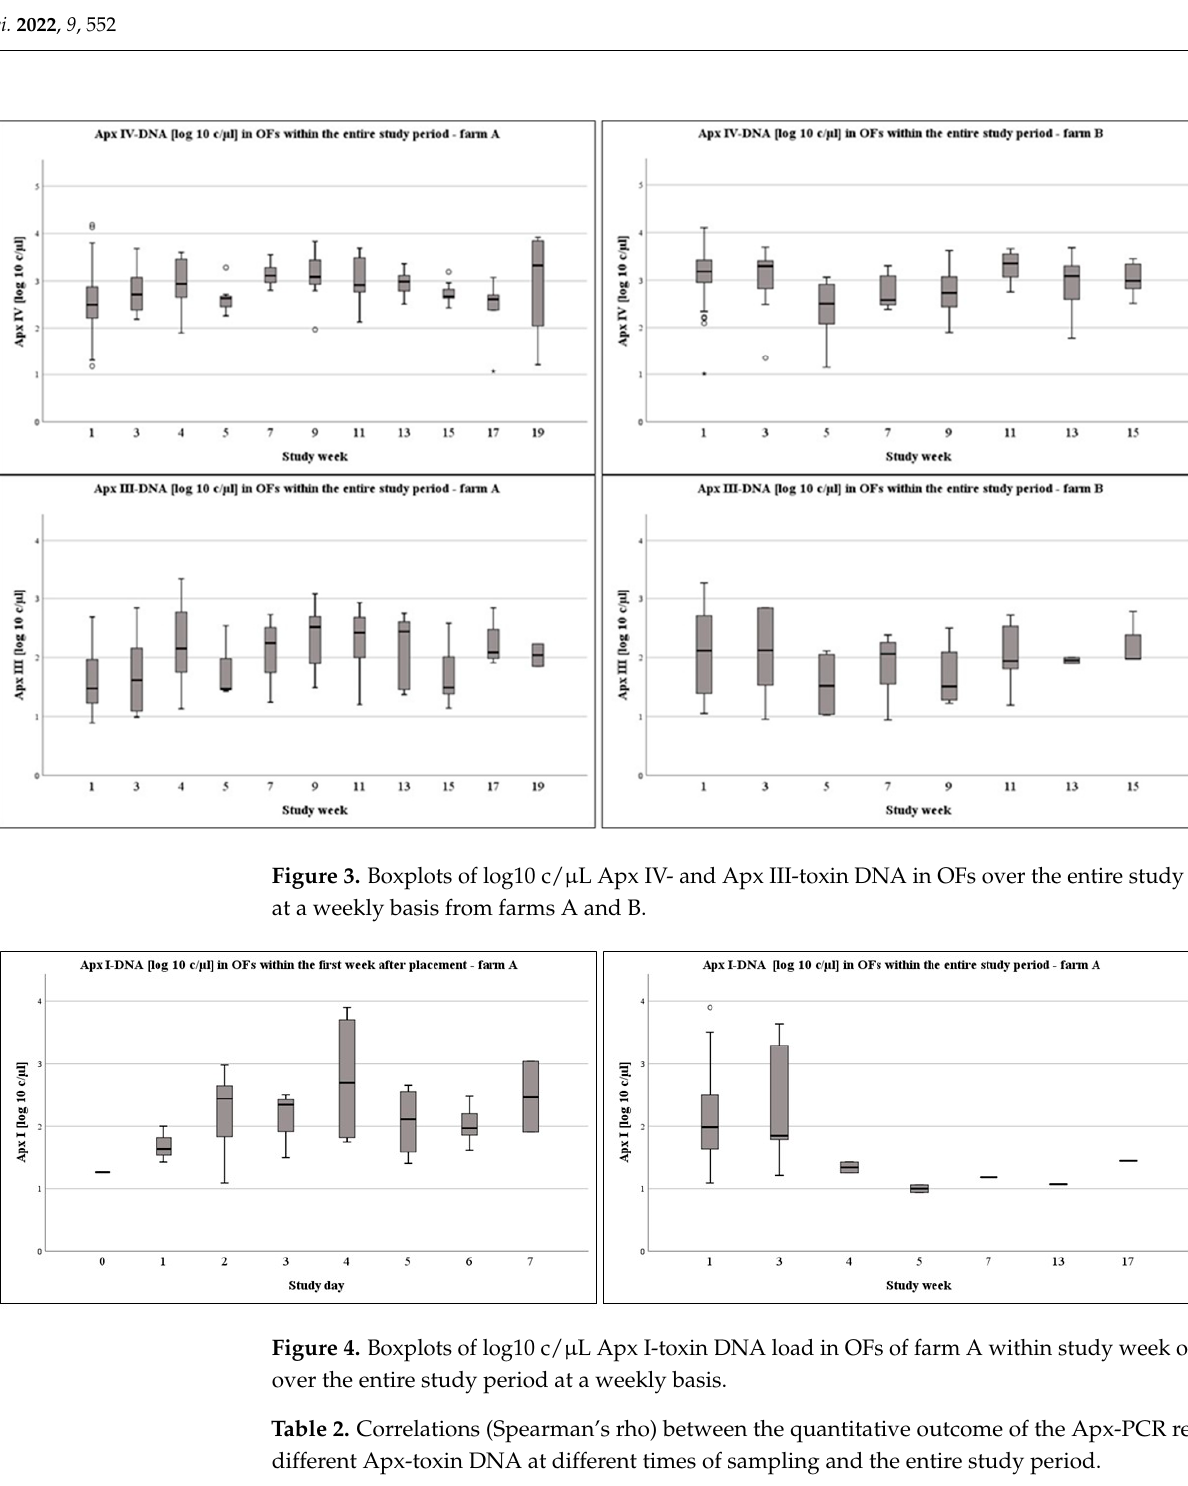
Table 2. Correlations (Spearman’s rho) between the quantitative outcome of the Apx-PCR result of different Apx-toxin DNA at different times of sampling and the entire study period.